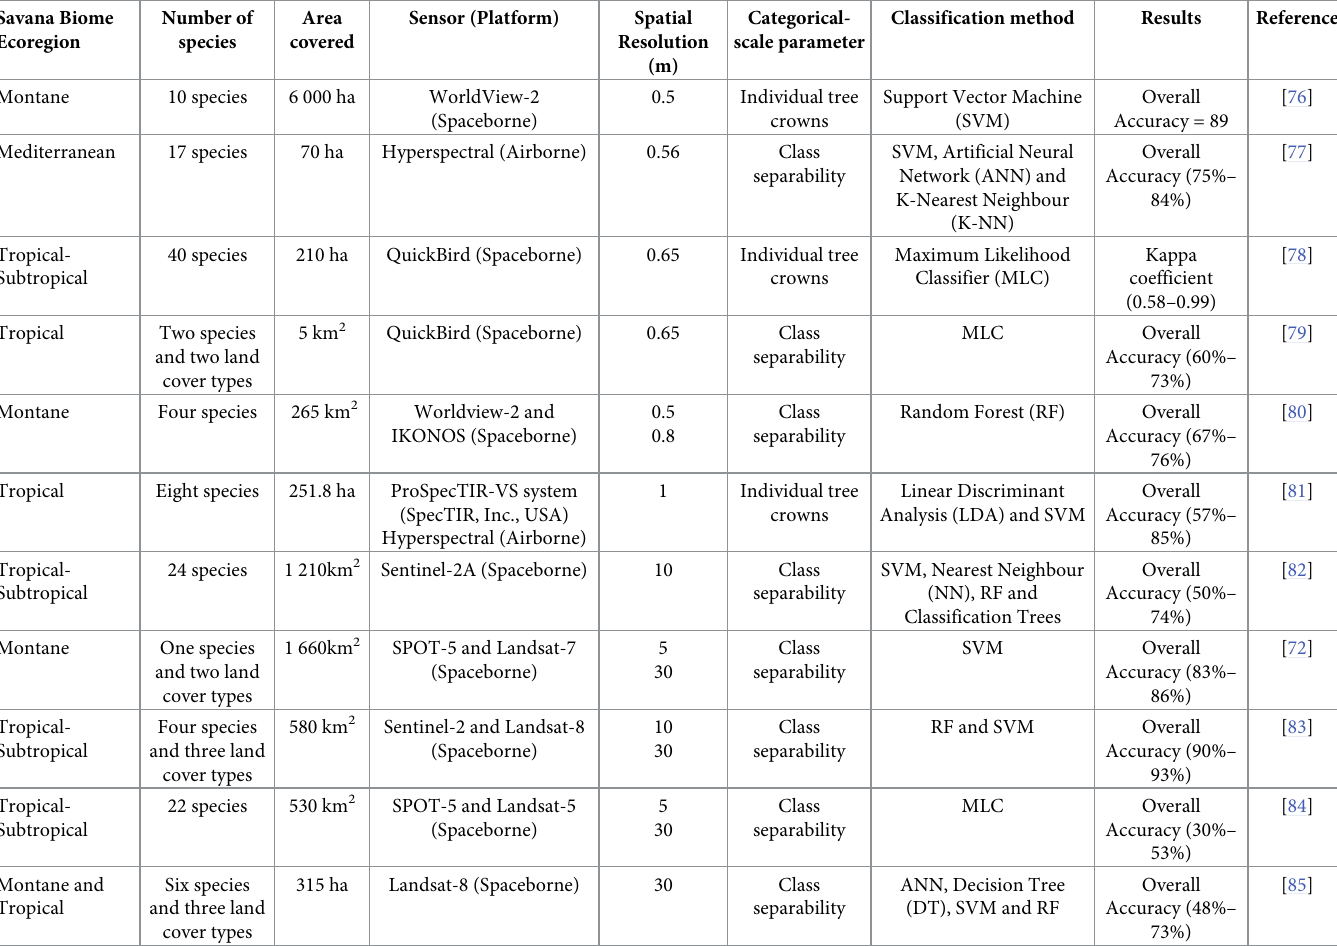
Table 1. Examples of studies that categorically classified woody plant species in savanna using optical remote sensing. Savana Biome